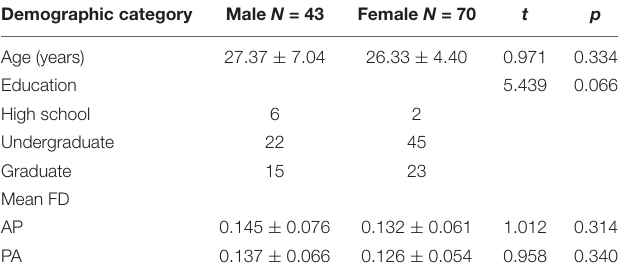
TABLE 1 | Demographic